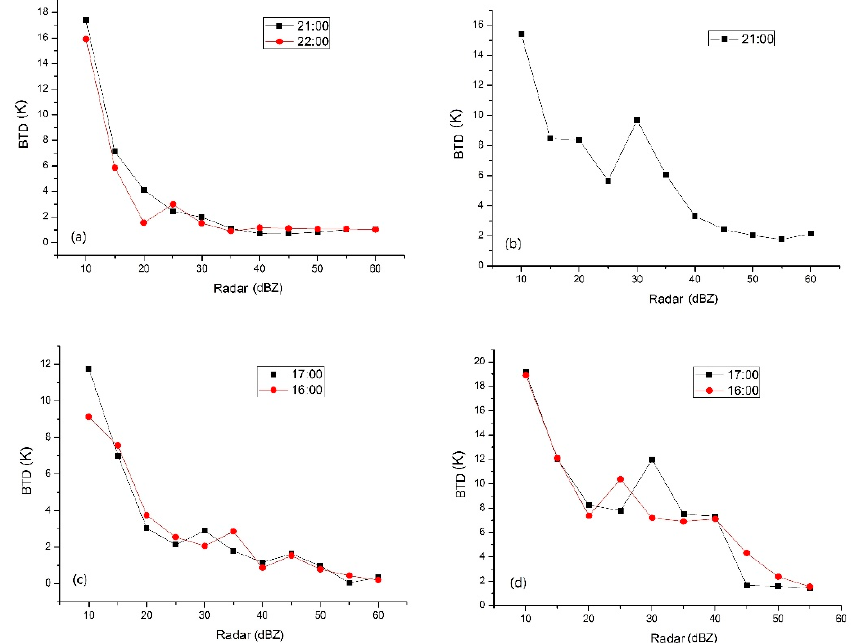
Figure 13. Relationship between satellite BTD and radar reflectivity factors Z for the analyzed case studies. ( a ) Relationship between BTD and Z on 25 June 2021; ( b ) relationship between BTD and Z on 30 June 2021; ( c ) relationship between BTD and Z on 1 July 2021; ( d ) relationship between BTD and Z on 9 August 2021.